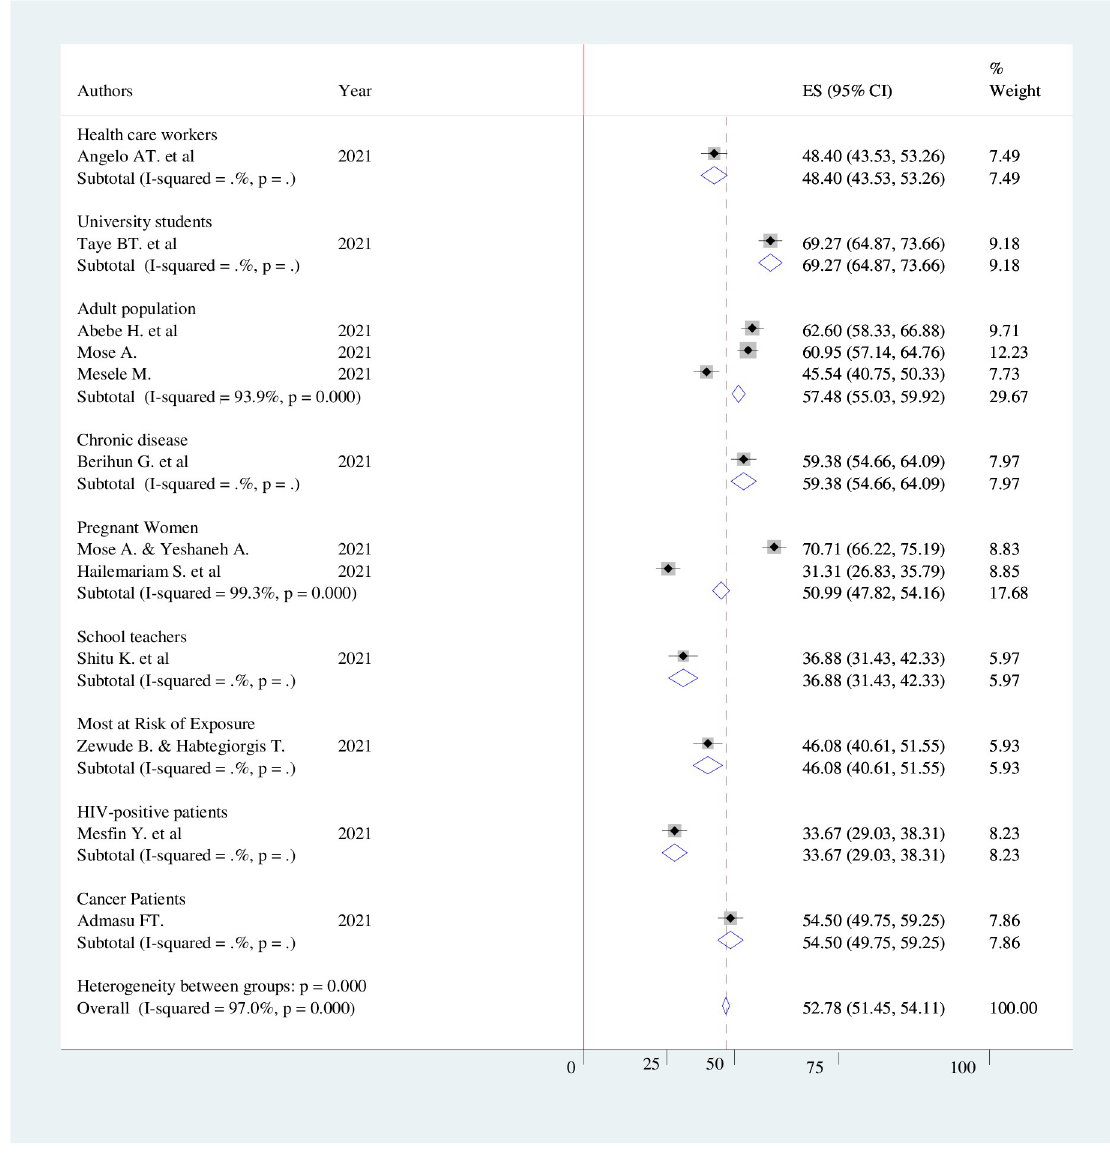
Fig 5. Forest plot showing sub group analysis of COVID-19 vaccine acceptance and its determinant factors by study population in Ethiopia, 2021.